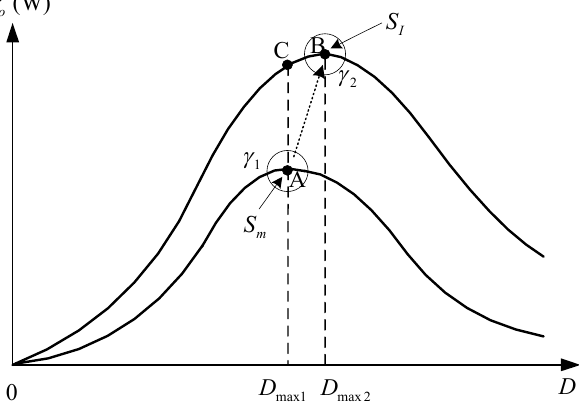
Figure 5. Characteristics of the MPP moving with the increasing irradiance. Table 4. Simulation results under increasing irradiance conditions.